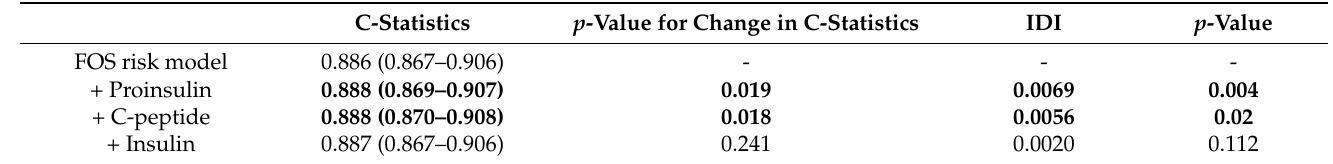
Table 3. Additive value of proinsulin, C-peptide, and insulin for the prediction of T2D in 5001 partici- pants of the PREVEND